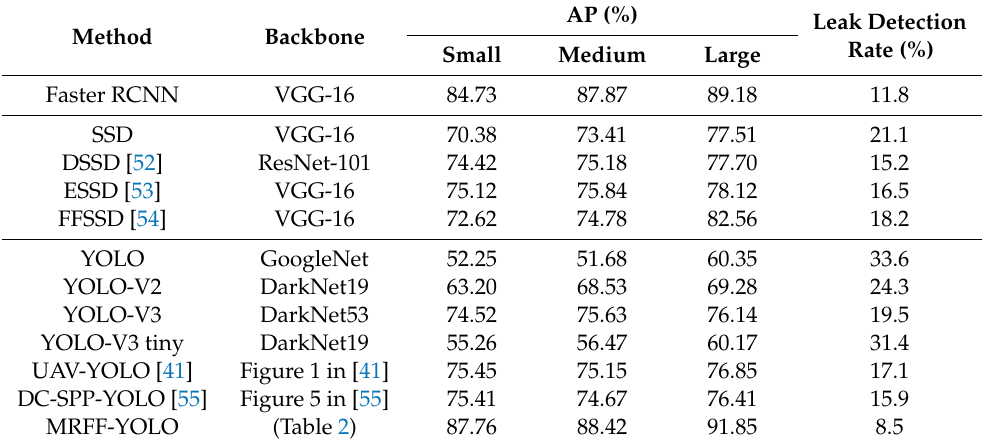
Table 10. The contrastive results of di ff erent sizes in the RSOD dataset.